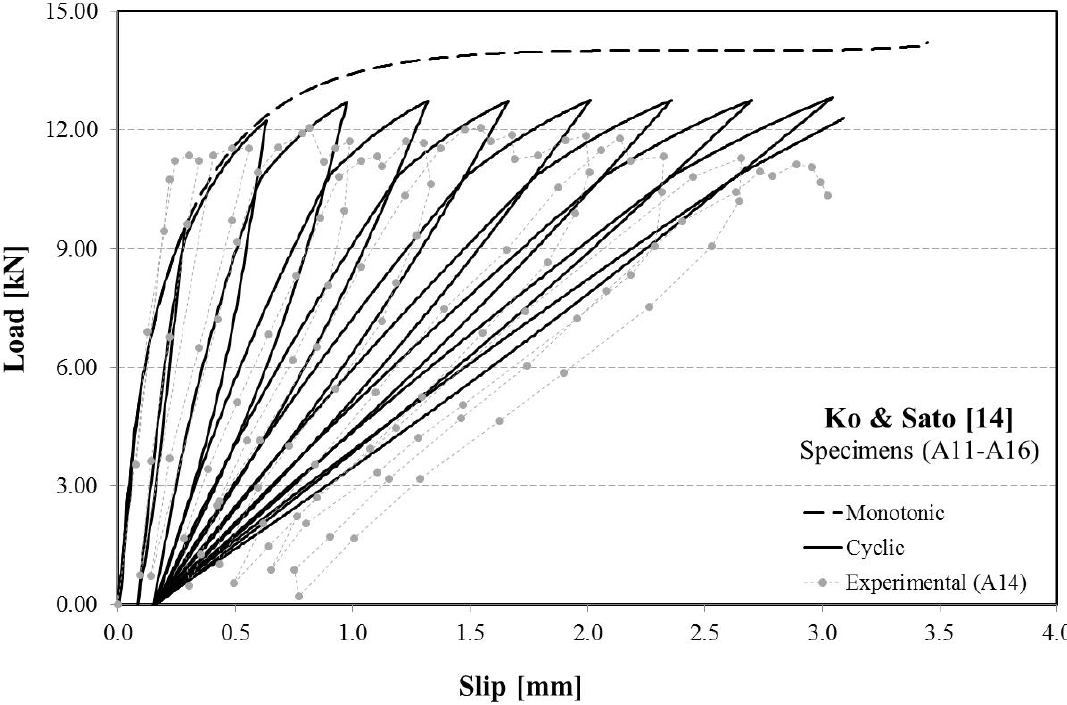
Figure 5. Load-slip response under monotonic and cyclic actions of FRP strips glued on concrete [14]—Exponential softening.